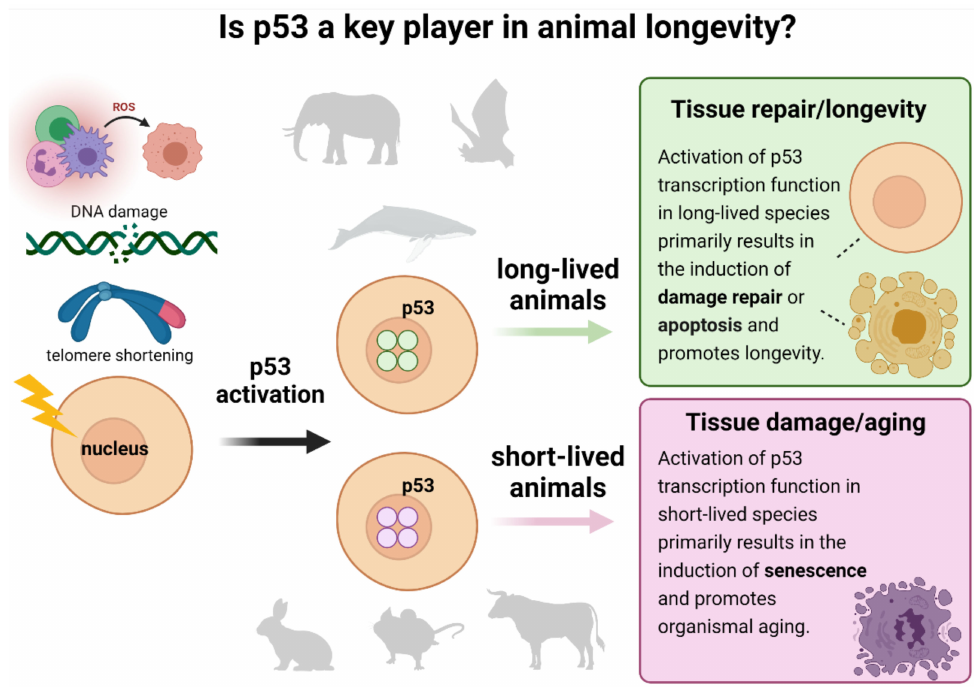
Figure 11. Proposed p53-centric theory of extreme longevity. Cell damage caused by ROS, DNA damage, telomere shortening, or other factors activates p53 to enable DNA repair and/or apoptosis. On the other hand, a high activity of p53 promotes organismal aging, thus shortening the lifespan. We hypothesize that long-lived animals developed the “improved” p53 proteins, which are less active than in their short-lived counterparts but still may sufficiently contribute to DNA damage repair and apoptosis in species that are exposed to environmental genotoxic